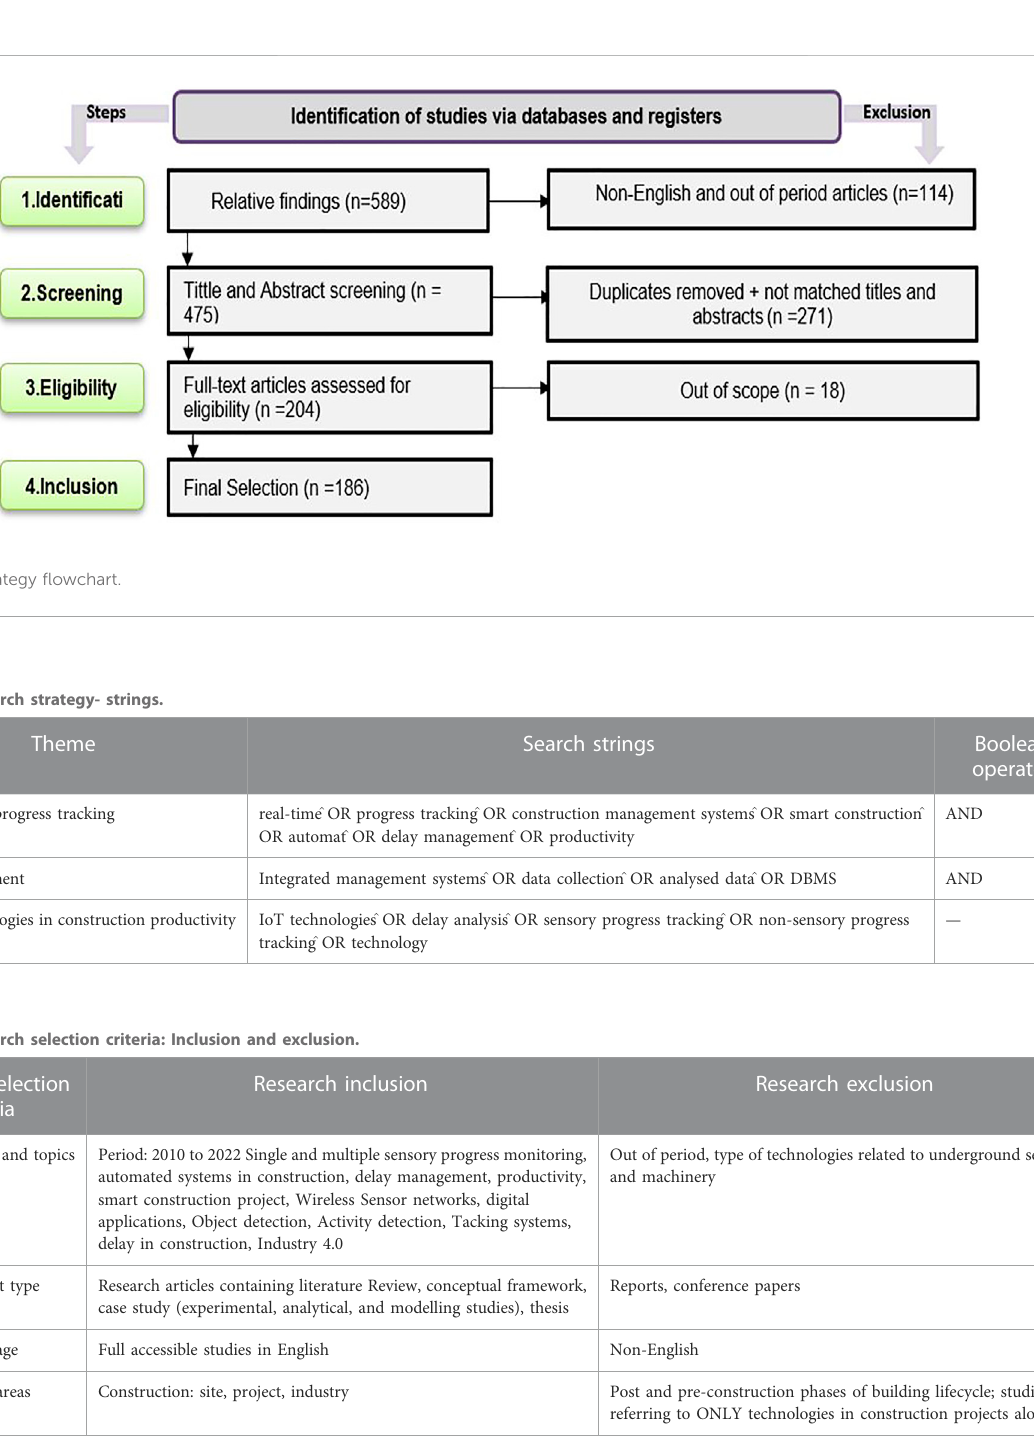
The selected keywords were classi fi ed into three themes for searching articles. The themes and selection of keywords are